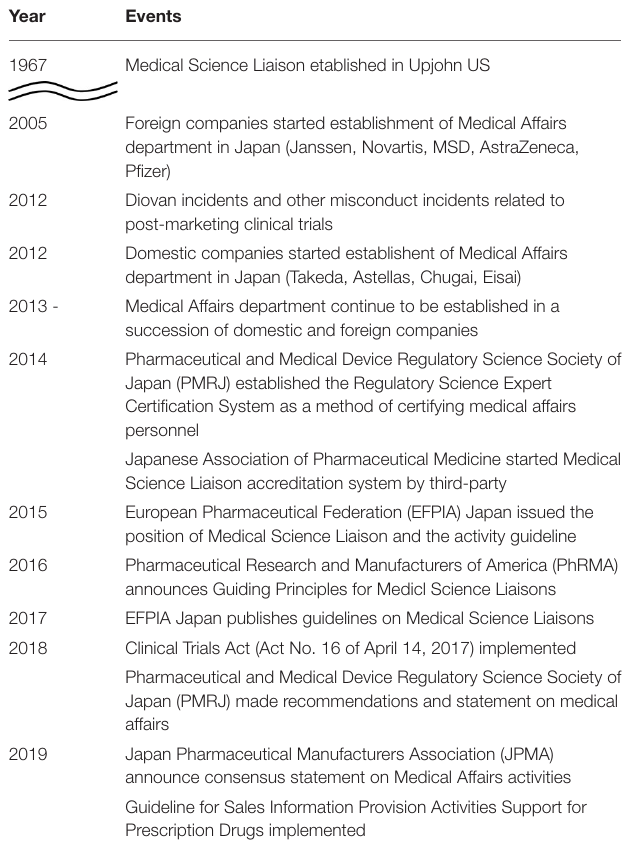
TABLE 1 | Major Events Related to Medical Affairs in